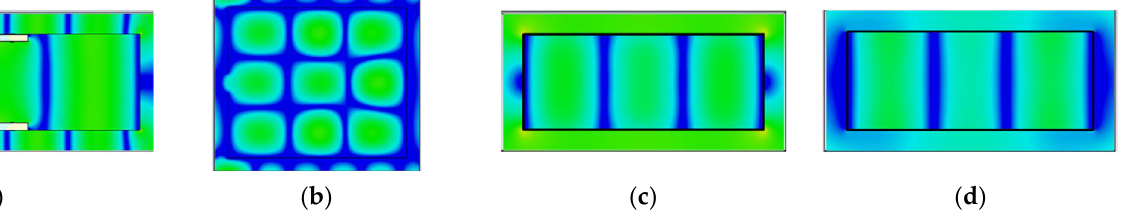
Figure 10. Mode303 field distribution of capacitive obstacles with a finite thickness. ( a ) x section, ( b ) y section, ( c ) z section of the front part, and ( d ) z section of the back part.